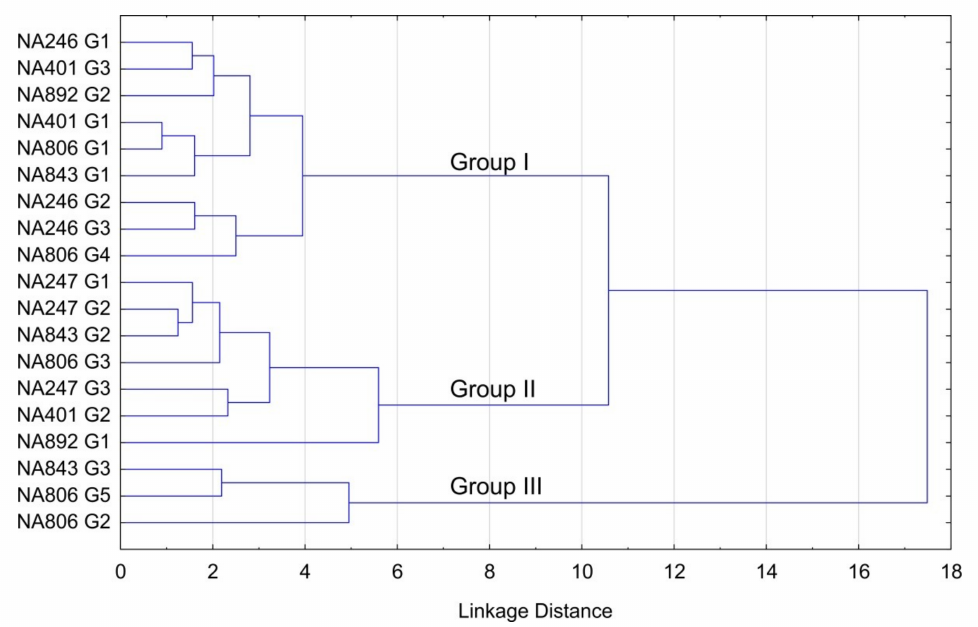
Figure 4. Three diagrams for 19 garnets of the S-fibulae based on Ward’s method and squared Euclidean distance using Raman mode frequencies.